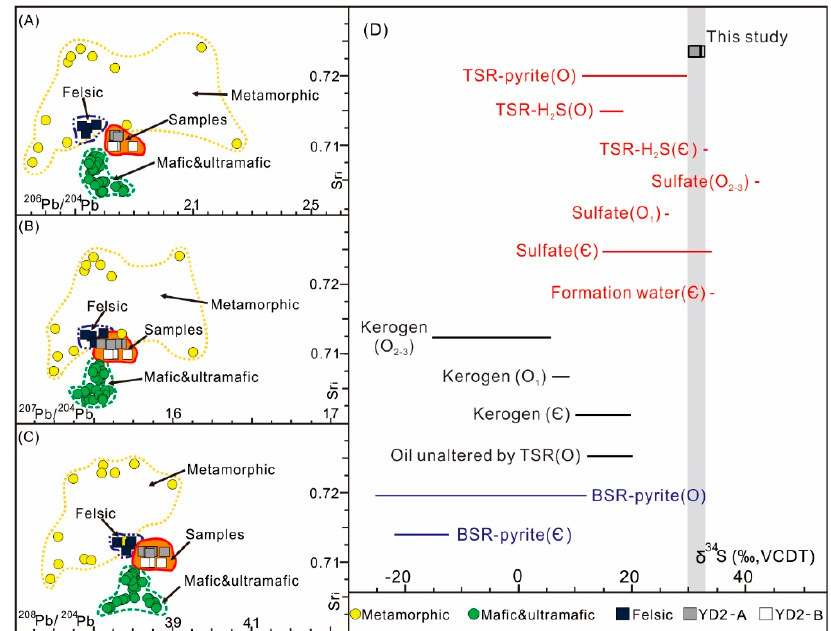
Figure 9. ( A ): Sr i - 206 Pb/ 204 Pb, ( B ): Sr i - 207 Pb/ 204 Pb, ( C ): Sr i - 208 Pb/ 204 Pb and ( D ): S isotope ratios of the pyrites in this study compared with spatially and temporally associated materials from the literature. Whole-rock Pb isotope ratios were corrected to their initial ratios. Є —Cambrian; O—Ordovician; TSR—thermochemical sulfate reduction; BSR—bacterial sulfate reduction; Sr i —initial 87 Sr/ 86 Sr value; VCDT—Vienna Canyon Diablo Troilite. Lead and strontium isotope data sources: (1) felsic rocks: [50,51];